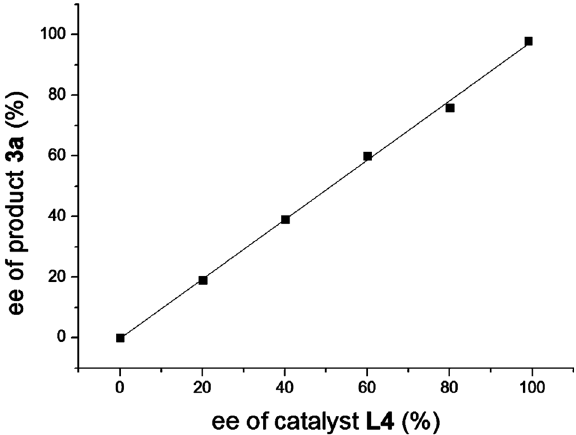
Fig.6|Mechanisminvestigation. Therelationshipbetweeneevaluesofligand L4 and product 3a .